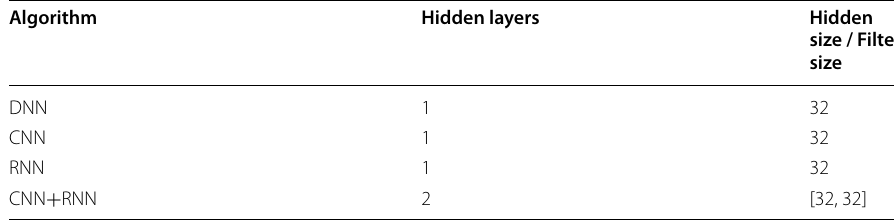
Table 6 Summary of Algorithms used